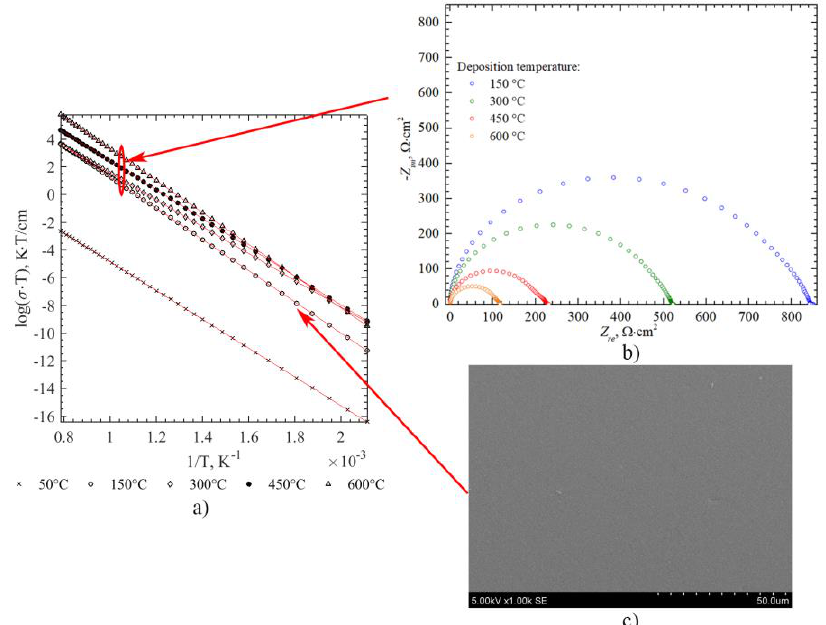
Figure 4. ( a ) Arrhenius plot and ( b ) Nyquist plots for SDC thin film deposited evaporating powder of 201.3 m 2 /g specific surface area on Al 2 O 3 substrates with a 0.4 nm/s deposition rate and 150–600 °C substrate temperature, and ( c ) a topography image of a thin SDC film deposited on an Al 2 O 3 substrate at 150 °C with a 0.4 nm/s deposition rate.